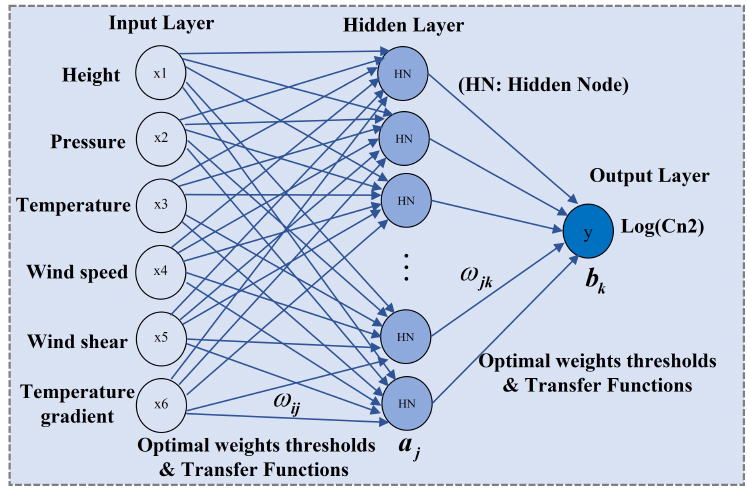
Figure 1. Topological structure diagram of the GA-BP neural network